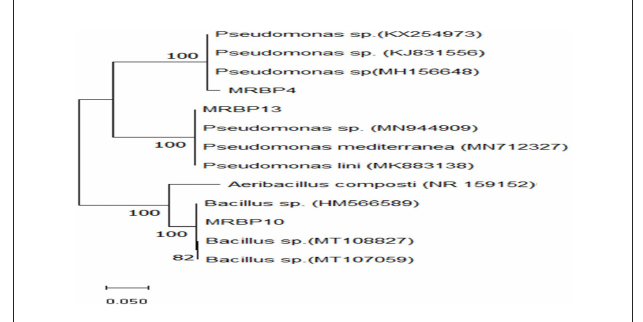
FIGURE1 Maximum Likelihood phylogenetic tree based on 16S rRNA gene sequence, using the neighbor-joining (NJ) algorithm. It shows the evolutionary relationships of the 3 rhizobacteria strains and their closest representative species obtained from the GenBank with Aeribacillus composti (NR159152) as the outgroup. The numbers at the nodes represent the levels of bootstrap support based on 1,000 resampled data sets. Bootstrap confidence levels > 50% are indicated at the internode.